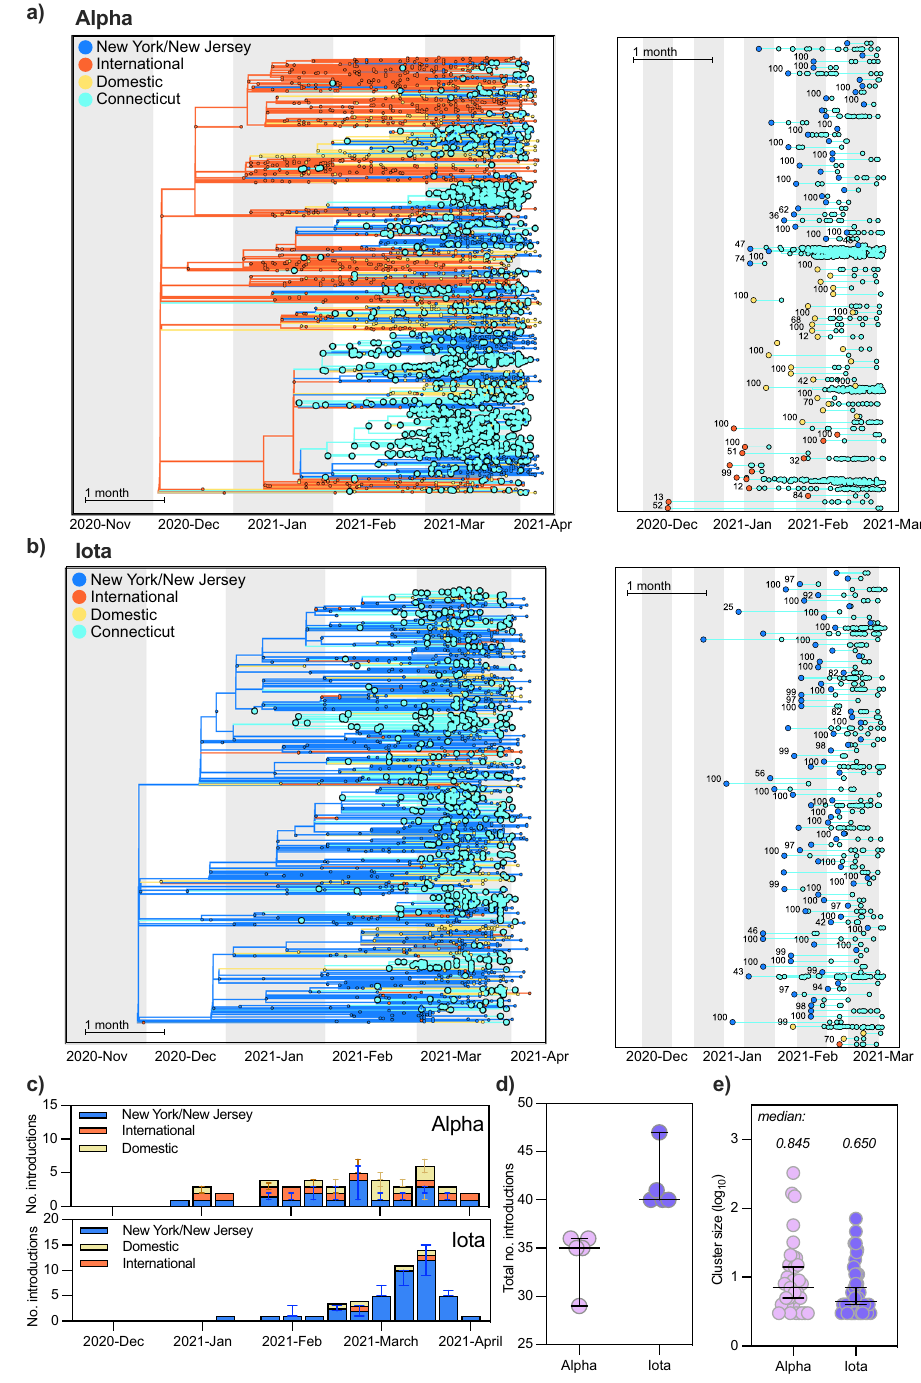
Fig. 3 Alpha was introduced into Connecticut at a similar frequency as Iota but was associated with larger cluster sizes. a , b Discrete phylogeography of Alpha ( a ) and Iota ( b ). Tips and nodes were assigned one of four possible locations: Connecticut, New York/New Jersey, domestic, and international. The phylogeographic analysis was performed in BEAST 23 using a time-resolved tree as the fi xed topology 24 . Bootstrap values for each clade are shown at each ancestral node (right) and were obtained by constructing individual maximum likelihood trees with 1000 ultrafast bootstraps in IQTree 26 . Clades without a support value were part of polytomies. c We summed the number of sustained introductions for each variant by week. We de fi ned sustained introductions as Connecticut-only clades containing at least 3 tips related by a non-Connecticut ancestor with at least 0.7 posterior probability for the inferred location. Bar colors indicate the source of introduction. Error bars show the range of the fi ve replicates per variant. d There were more sustained introductions of Iota than Alpha into Connecticut. The horiztonal bars show the median and 95% CI over fi ve replicates per variant. e The size of Alpha clades in Connecticut was on average larger than Iota clades in Connecticut. We calculated the log 10 size of Connecticut clades shown in a , b . The horizontal lines denote the median and 95% CI log cluster